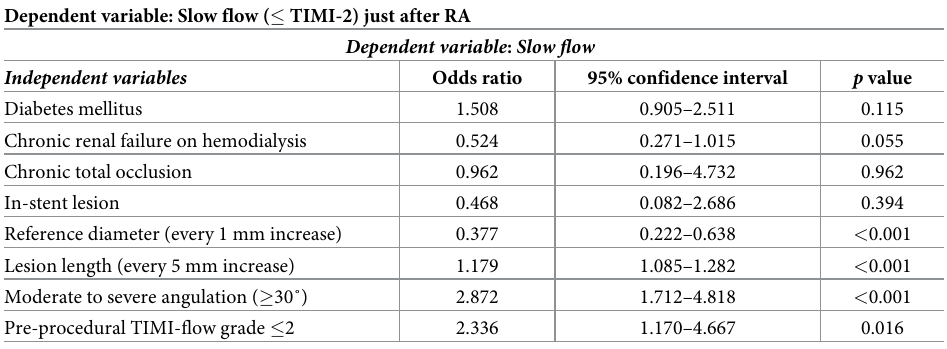
Table 3. Multivariate logistic regression model to find unmodifiable factors associated with slow flow. Dependent variable: Slow flow ( � TIMI-2) just after